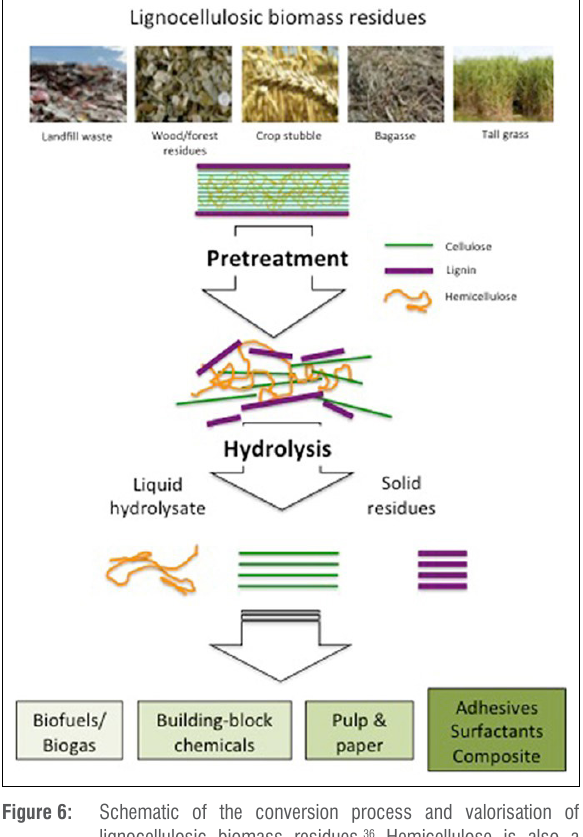
Figure 6: Schematic of the conversion process and valorisation of lignocellulosic biomass residues. 36 Hemicellulose is also a good candidate for biocomposites for solid-state biomass strong materials. Tannin, a natural macromolecular biomass resource mainly found in